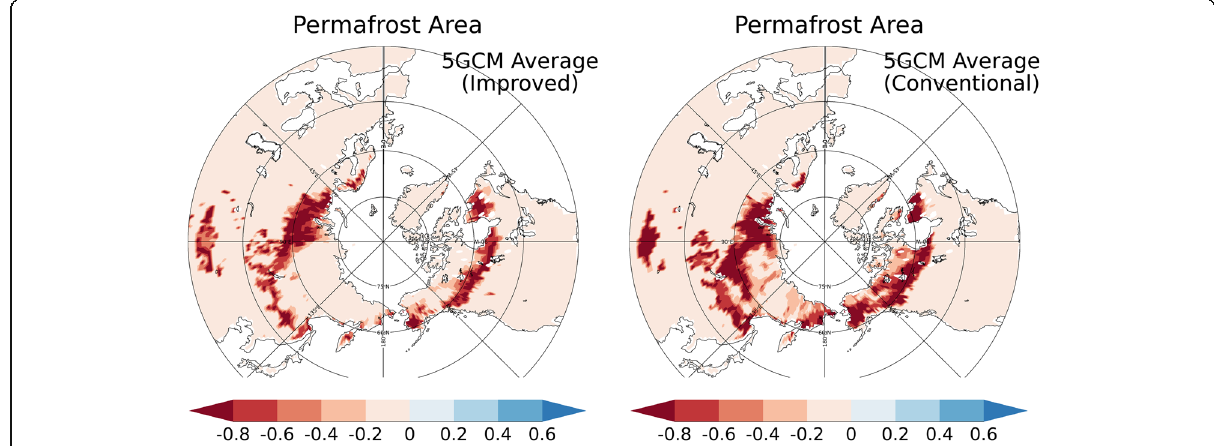
Fig. 10 Changes in the permafrost distribution projected by the study ’ s future projection simulations. The current permafrost area is set at 1.0. Average values for the simulations with atmospheric forcings by the five GCMs are plotted. The difference between the average for 2081 –